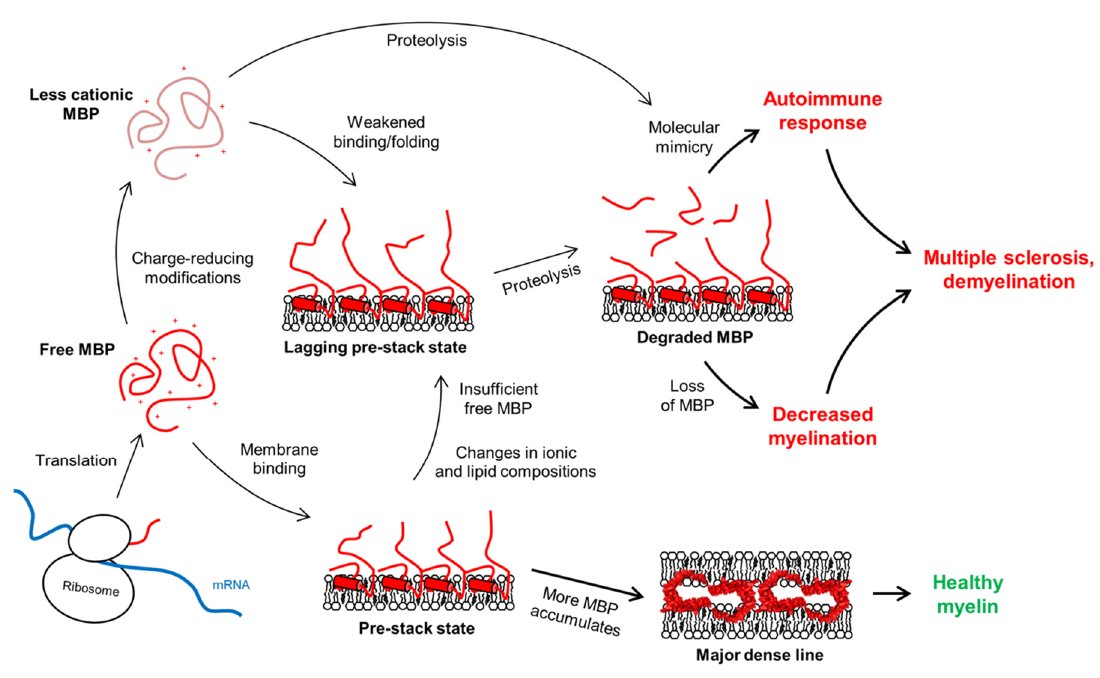
Figure 10. The fate of the MDL formation is governed by the concentration of active MBP (red), which normally would associate with membranes, form a pre-stack state, and continue to accumulate until stable membrane stacks form. MS is linked to an autoimmune response and loss of myelin, which could stem from molecular mimicry. The immune system recognizes antigenic MBP peptides formed via proteolysis of free or membrane-bound MBP. Changes in membrane lipid composition or concentration of intracellular ions could pre-expose to this process [53,90]. Changes in the PTMs of MBP have additionally been shown to play a role [60,226,239], as might lowered MBP expression levels [24].